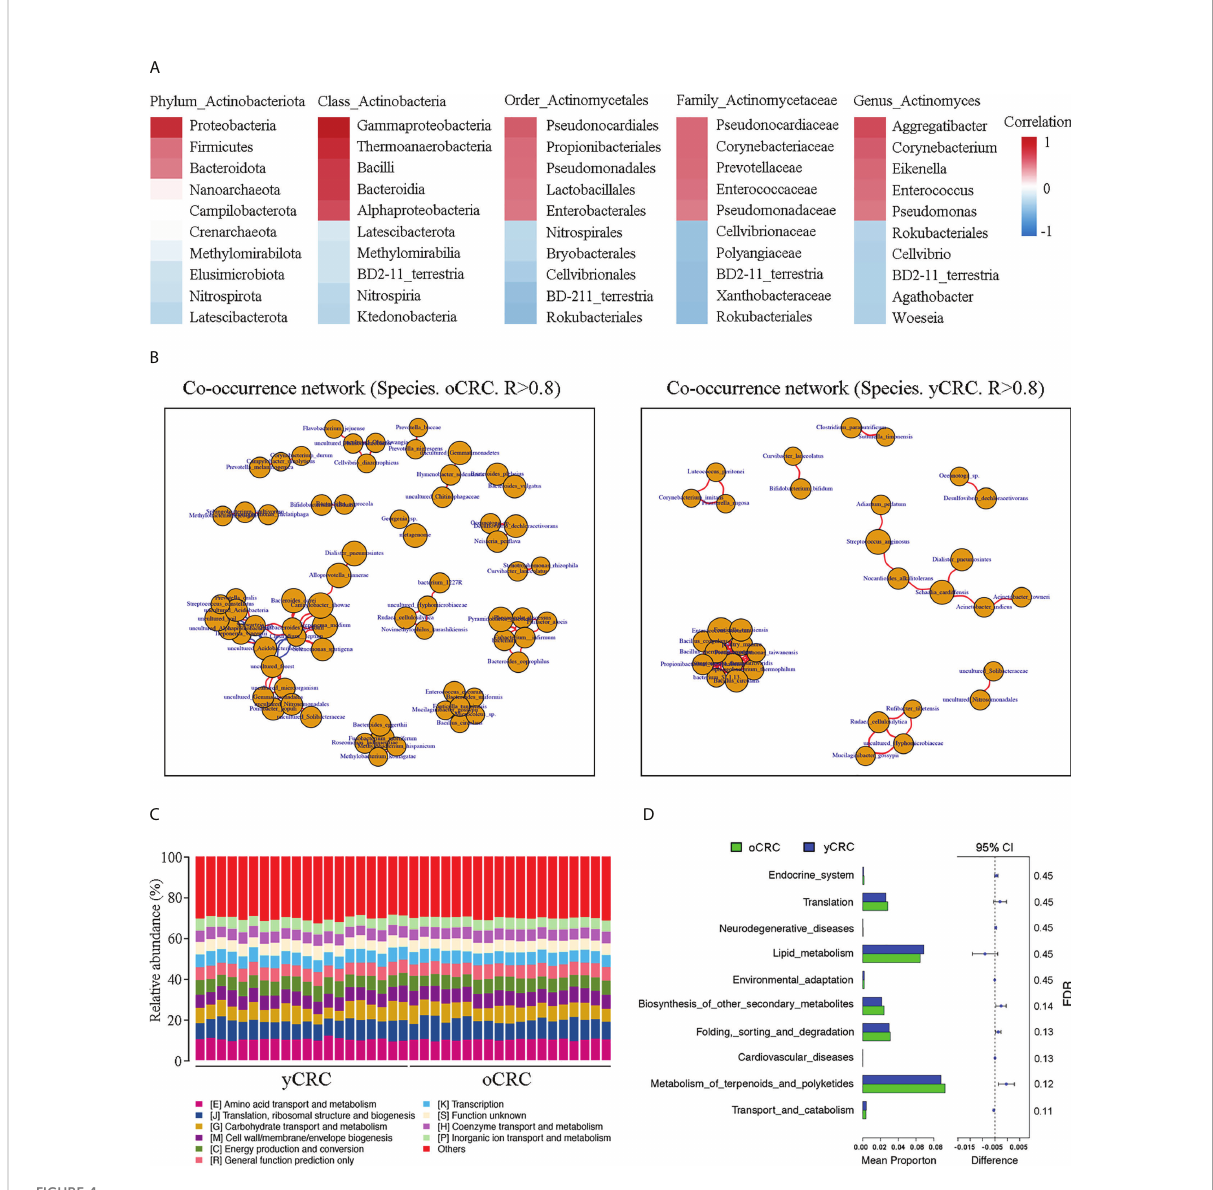
FIGURE 4 Correlation of Actinomyces with differentially abundant genera and functional prediction of the tumor microbiome in CRC. (A) Correlation heatmap. Red indicates positive correlations; blue indicates negative correlations. (B) Co-occurrence network of oCRC and yCRC. (C) PICRUSt analysis identi fi ed 10 core predicted categories present in all CRC samples. (D) Gene functions in tumor microbiota in patients with oCRC and patients with